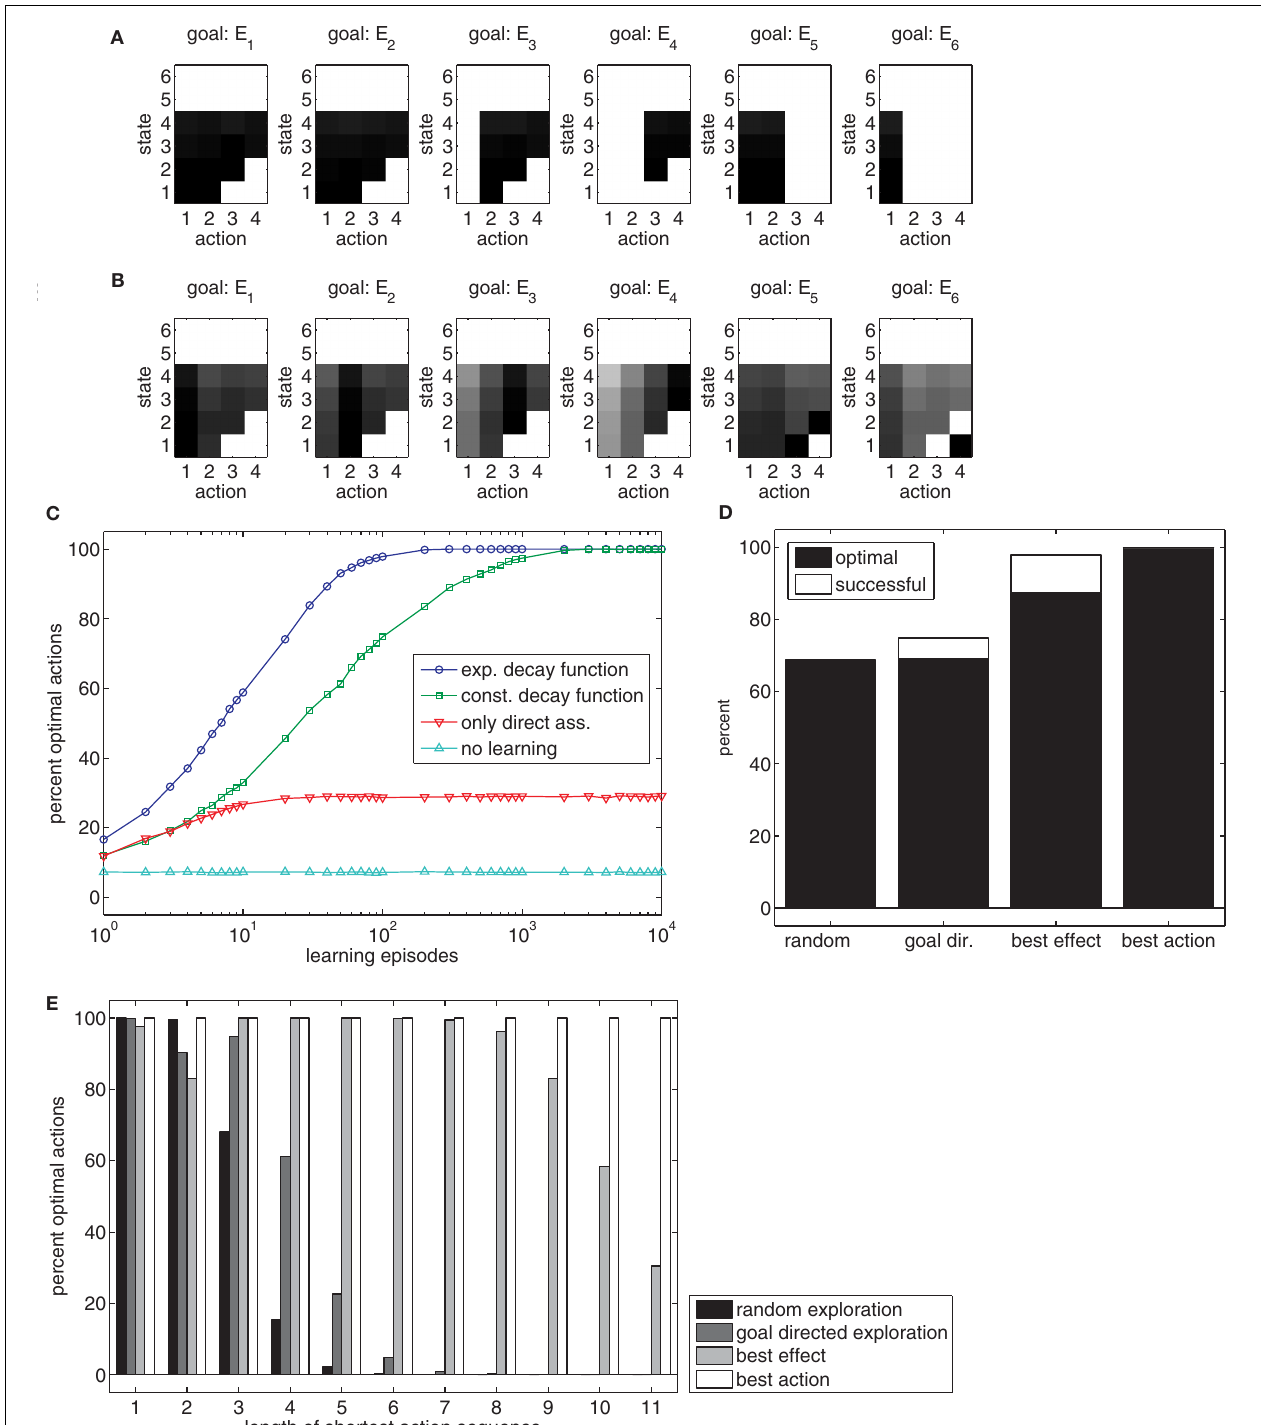
chart shows how frequently goals are reached optimally (i.e., with a minimal actions sequence) with different trace decay functions. (D) The chart shows how efficient goals that require sequencing of at least two actions can be reached dependent on the learning method in a setup with 12 action nodes. (E) The chart shows how efficient goals can be reached, dependent on the minimal number of actions that need to be sequenced to reach the goal and dependent on the learning